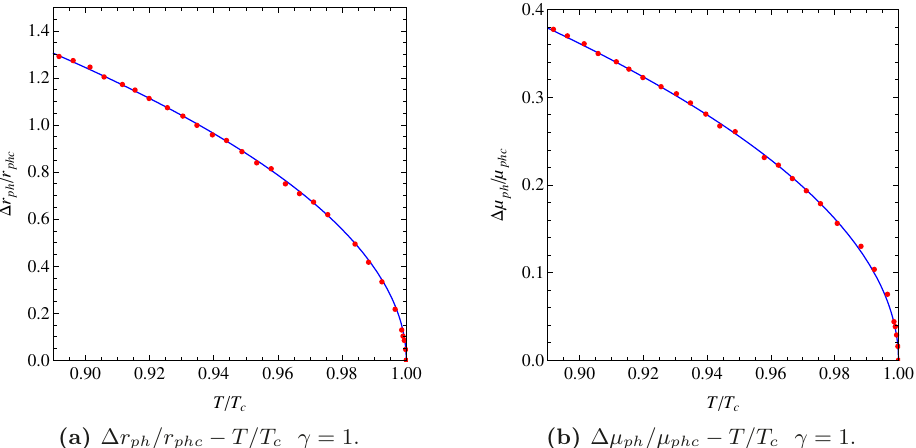
Figure 9. The parameters set to q = 1 . 9 and γ = 1. The pressure varies from P c P c + 0 . 0002 from bottom to top.